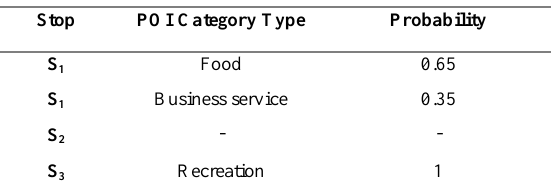
Table 5. Most probable POI category type.